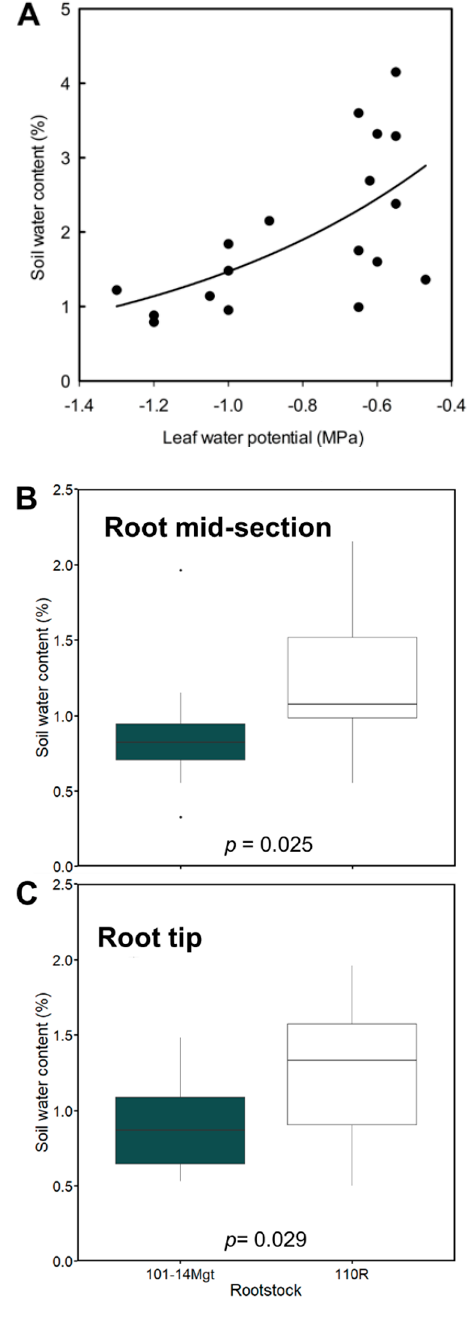
Figure 3. ( A ) Relation between soil water content (%) and stem water potential (MPa) (solid line is best fit, y = 5.27 * exp (1.27x) , R 2 = 0.37, p = 0.006). In ( B , C ), soil water content (%) associated with the presence of cortical lacunae in the root mid-section ( B ) and root tip ( C ). p -values in ( B , C ) were determined using t -test.